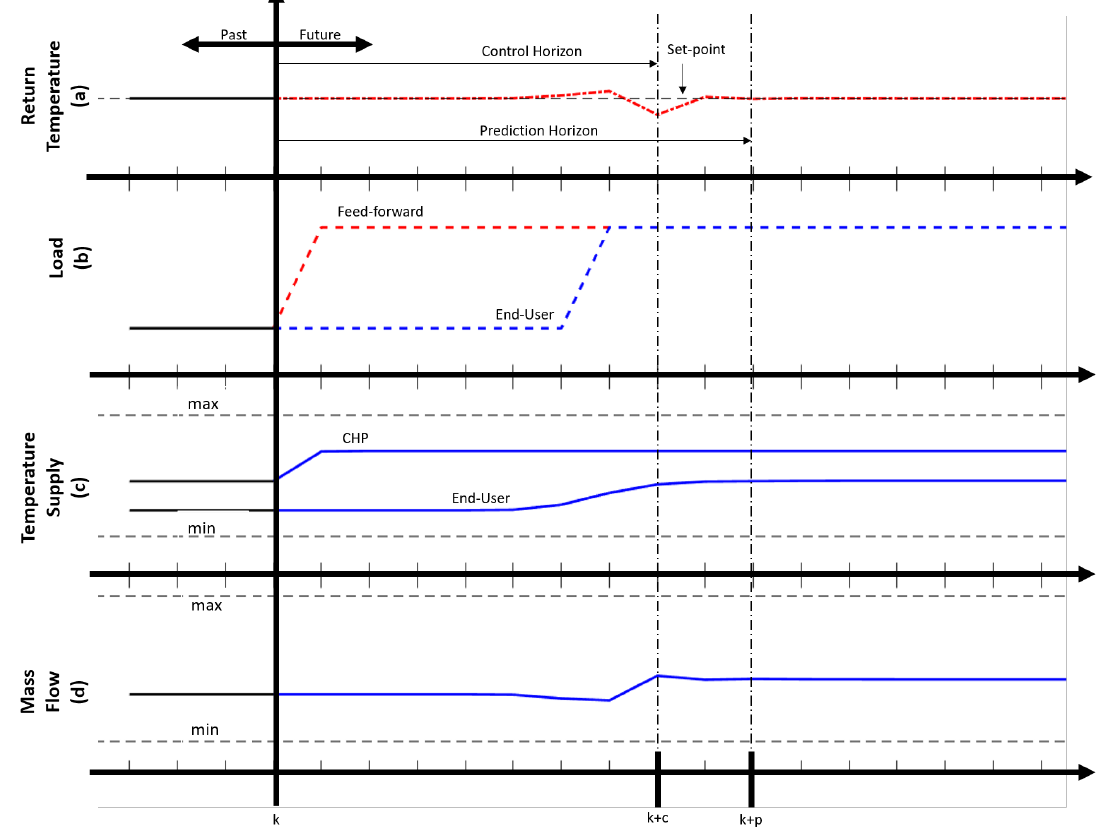
Figure 3. MPC step response: ( a ) return temperature operating around set-point, ( b ) feed-forward load and actual end-user load ( c ) actuation of CHP supply temperature and resulting end-user supply temperature, ( d ) actuation of mass flow